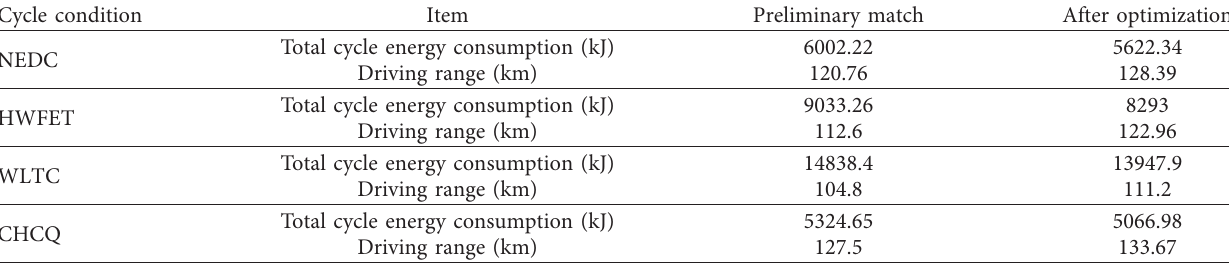
Table 5: Comparison of economic performance indicators after